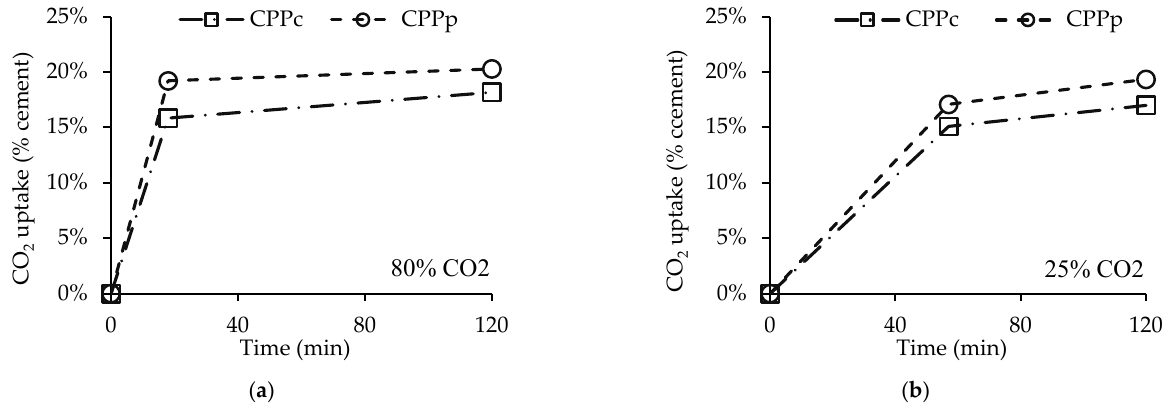
Figure 11. CO 2 uptake over time for CPPc and CPPp for CO 2 carbonation of 80% ( a ) and 25% ( b